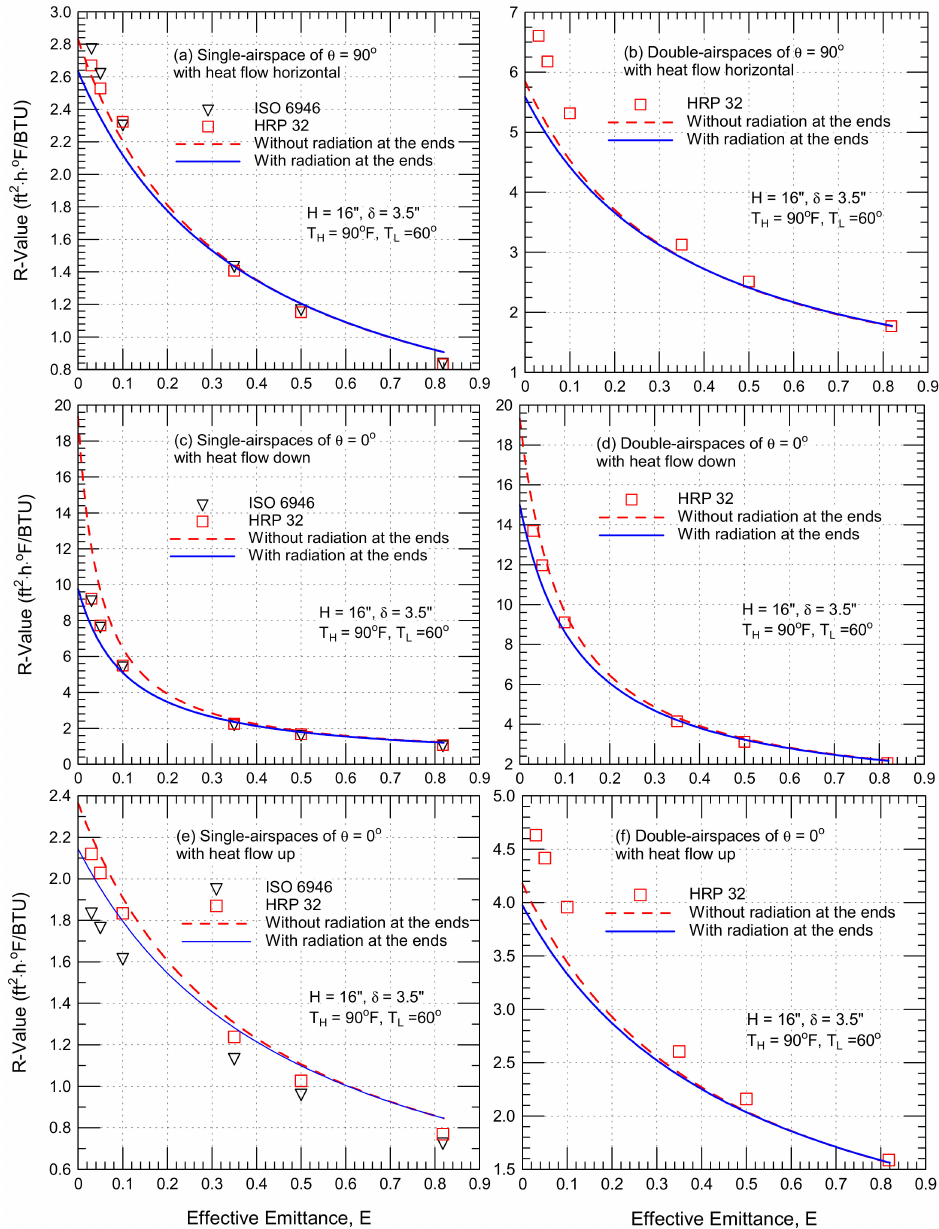
Figure 8. Effect of effective emittance on the thermal resistances of a single airspace and double airspaces with end effect (i.e., ε 3 = 0.9) and without end effect (i.e., ε 3 = 0.0) of θ = 0 ◦ and 90 ◦ at H = 16 inches and total δ = 3.5 inches for a